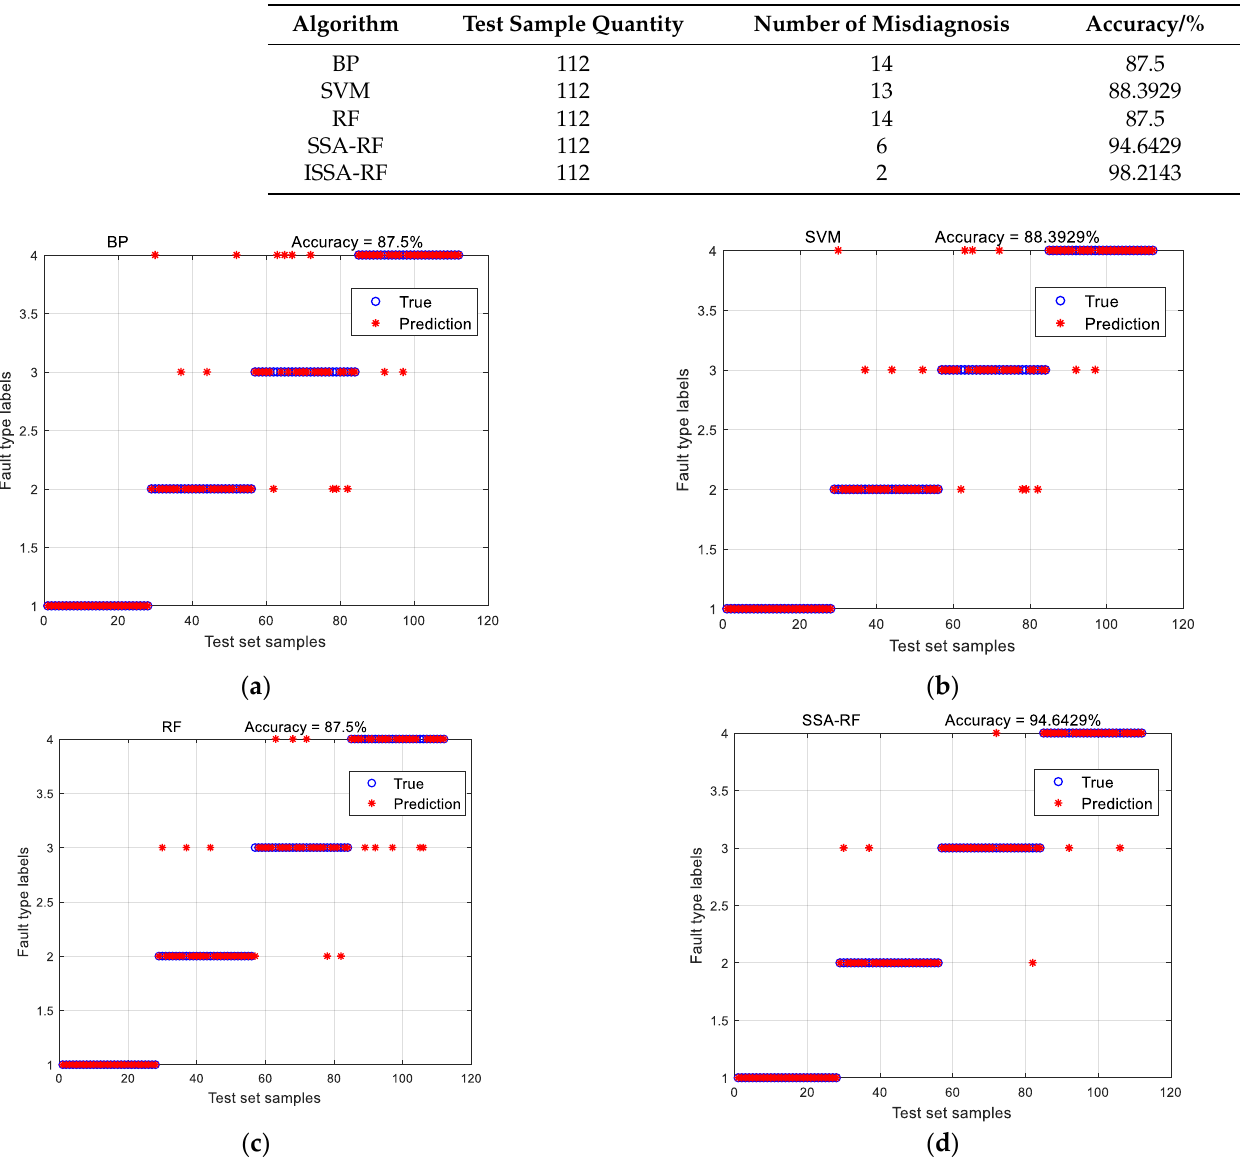
Table 5. Comparison of Fault Diagnosis Results of Each Algorithm.